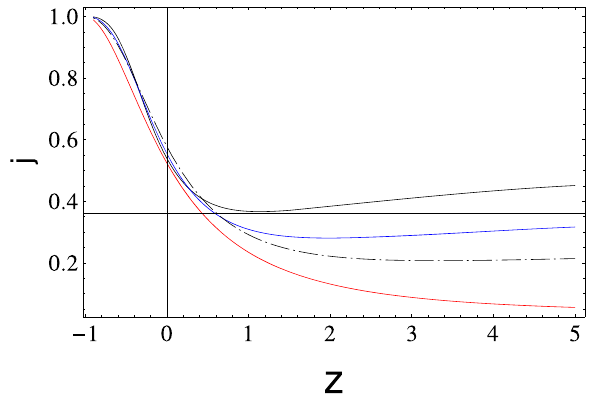
Fig. 4 The evolution of the cosmic jerk parameter j ( z ) is shown for δ = 1 . 4, (cid:5) 0 = 0 . 73 and different values of b 2 D upper panel of Fig.